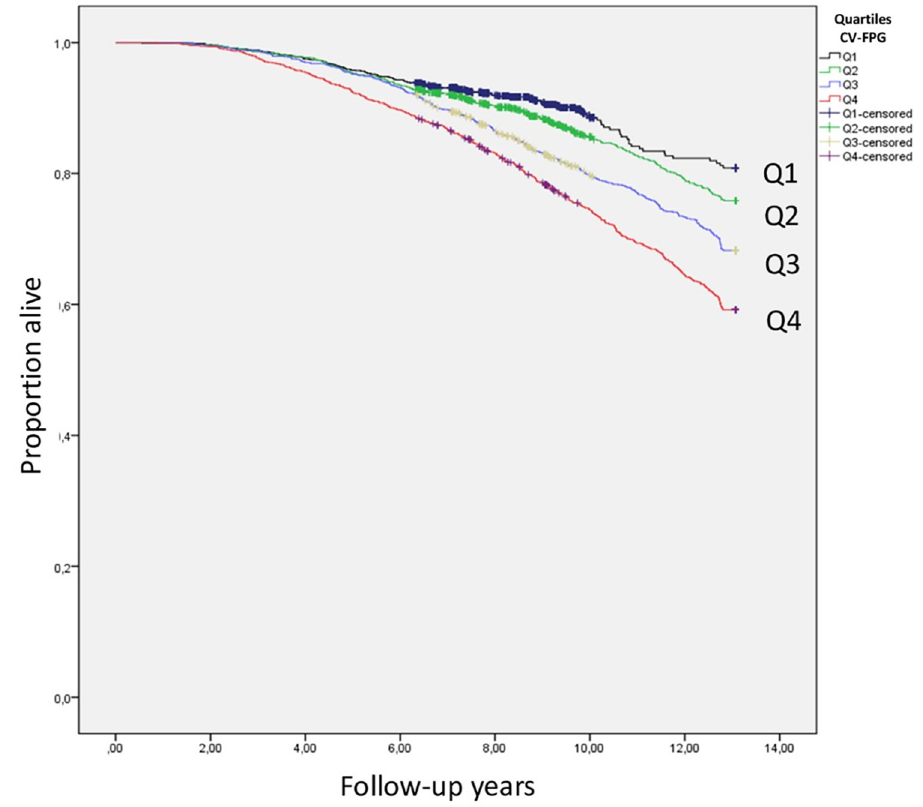
Fig 3. Crude all-cause mortality according to quartiles of the coefficient of variation of fasting plasma glucose levels (5,130 subjects with normoglycemia, prediabetes, or T2DM).